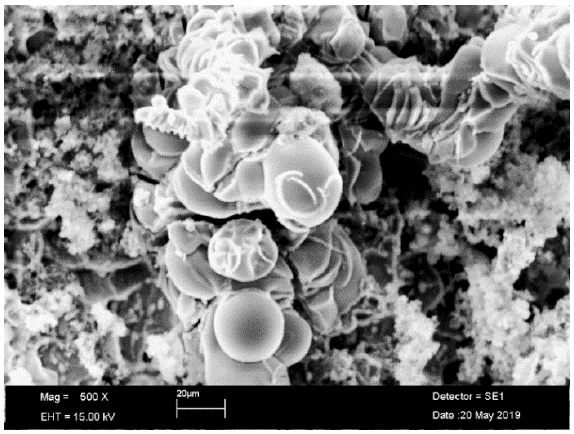
Fig. 11. EDX of rolled & 50°C annealed after SCC testing.